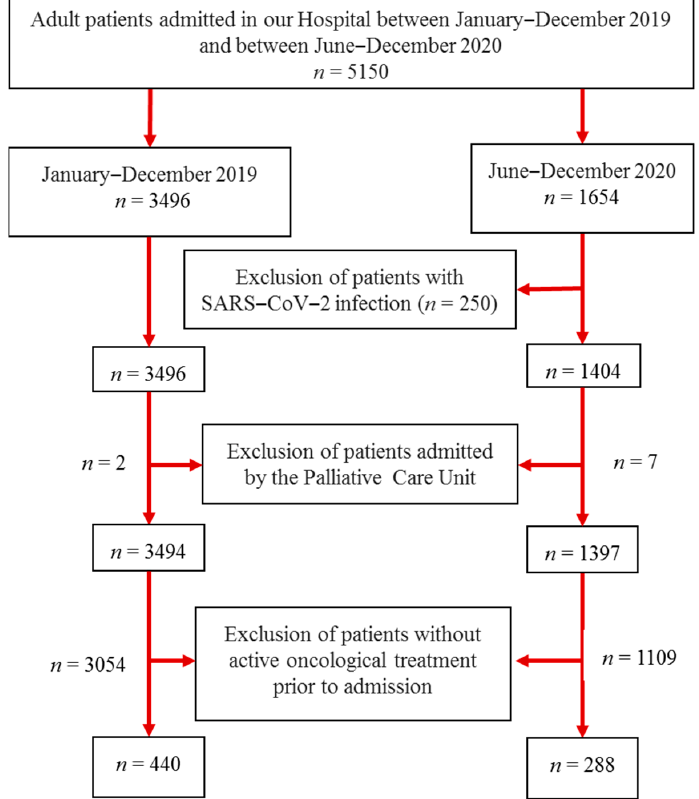
Figure 1. Flow chart describing the patient’s selection criteria.